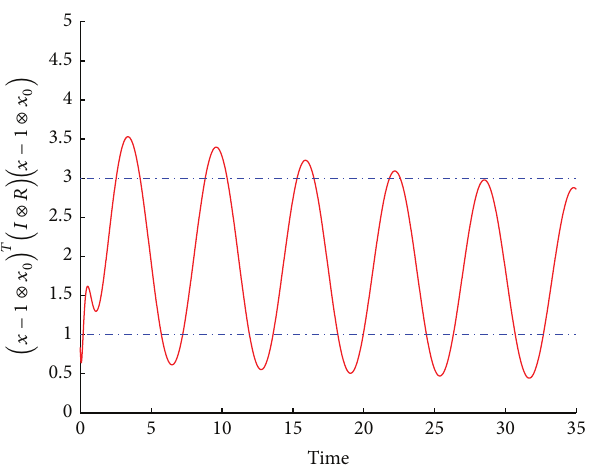
Figure 2: The error trajectories between the leader and each agent.